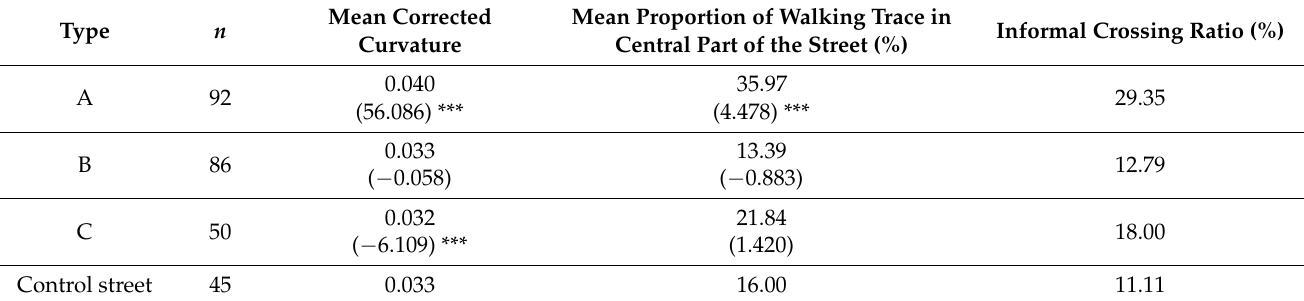
Table 8. Comparison of degrees of free walking in Pedestrian Priority Streets (PPSs) by design type.